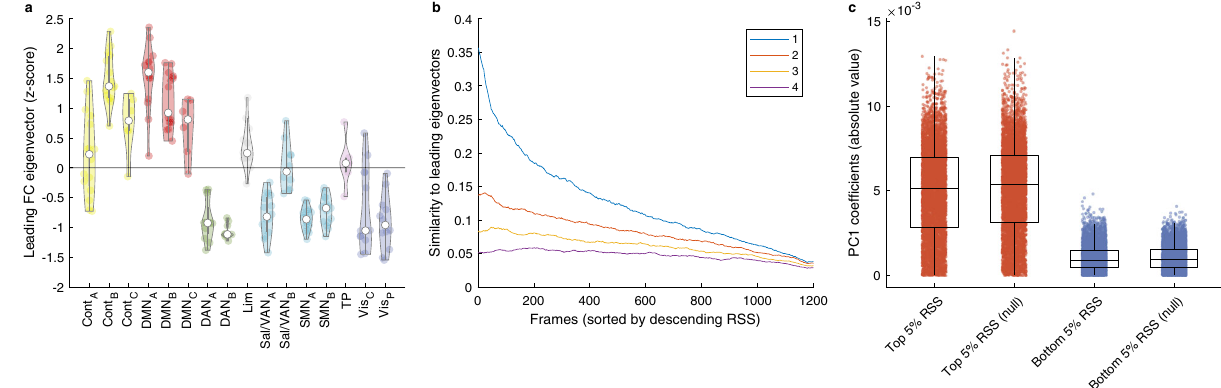
Fig. 5 The static Gaussian null model can explain the spatial patterns of BOLD activity and the co fl uctuation patterns that characterise high-amplitude frames. a The spatial mode underpinning high-amplitude co fl uctuations is captured by the leading eigenvector of the nFC matrix. The 200 brain regions were partitioned into the same 16 networks used in ref. 16 (Fig. 2e) to facilitate a visual comparison. In addition to a scatter plot of the data, the violin plots show the probability densities and the box plots indicate the quartiles, with the maximum whisker length speci fi ed as 1.5 times the interquartile range. The sample sizes of the box plots are the sizes of the 16 networks, that is, n = [16, 15, 6, 14, 17, 6, 12, 10, 14, 16, 10, 19, 15, 6, 12, 12]. b Frames corresponding to large RSS values exhibit high similarity to the leading nFC eigenvectors. The similarity is measured as the Pearson correlation between the instantaneous FC estimate from a single frame and each of the estimates from the four leading nFC eigenvectors. c Higher principal component (PC1) coef fi cients are associated with large RSS events. In addition to a scatter plot of the data, the box plots indicate the quartiles and the whisker length is speci fi ed as 1.5 times the interquartile range (sample size n = 6000). Compare this fi gure with the results published in ref. 16 (Fig.